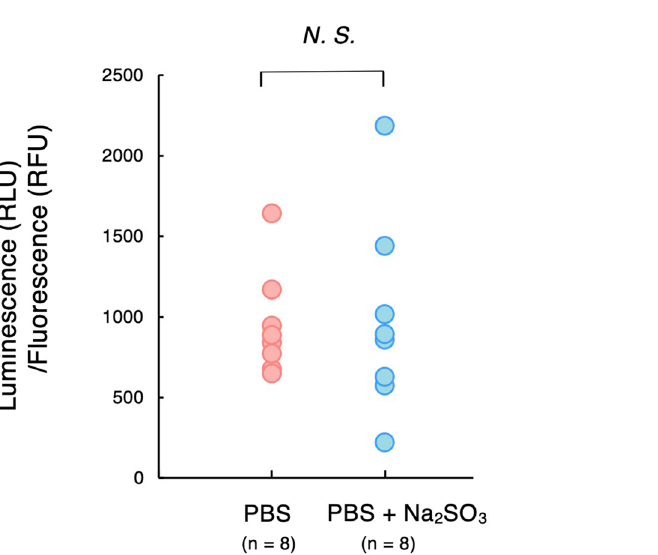
Figure 3. Effect of mitochondrial ATP production and glycolysis inhibitors on sperm motility. The asterisk indicates a statistically significant difference compared with the control at p < 0.05, based on a Kruskal–Wallis H test and Steel’s multiple comparison Wilcoxon tests.